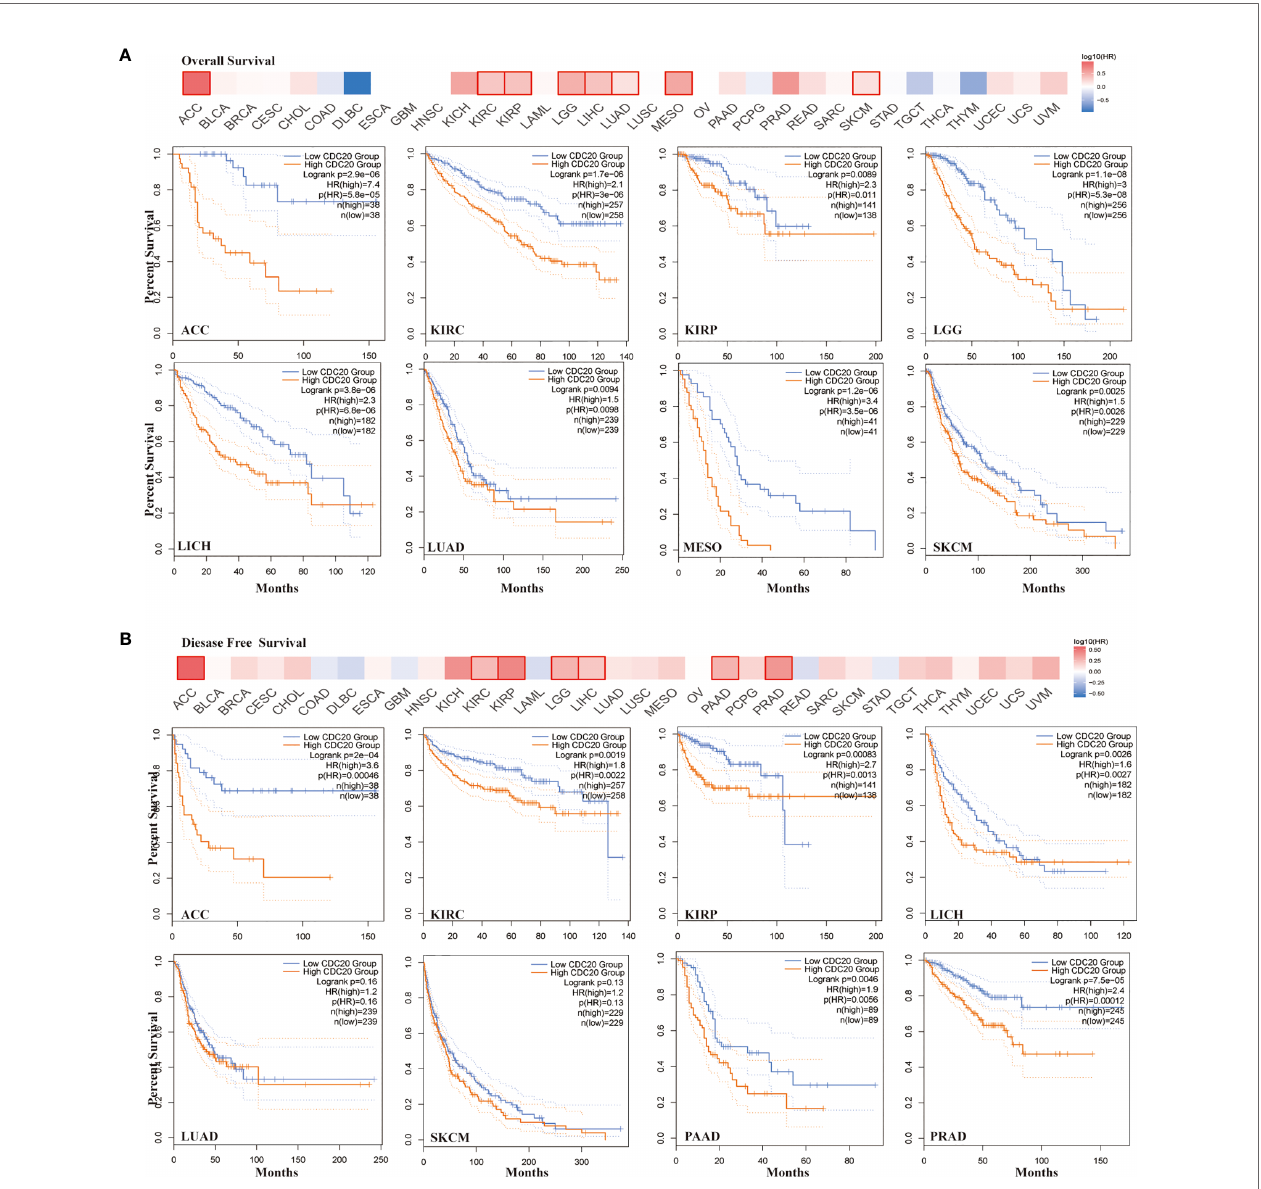
FIGURE 2 | Correlation between CDC20 expression levels and survival of different cancers from TCGA dataset. (A) The heatmap of overall survival analysis across 33 types of cancer from TCGA dataset (upper). In the heatmap, the bold box border indicated that the overall survival difference between CDC20 high and low expression cases was signi fi cant (P < 0.05). The survival plot of indicated cancer types was presented below the heatmap. (B) The heatmap of disease-free survival analysis across 33 types of cancer from TCGA dataset (upper). In the heatmap, the bold box border indicated that the disease-free survival difference between CDC20 high and low expression cases was signi fi cant (P < 0.05). The survival plot of indicated cancer types was presented below the